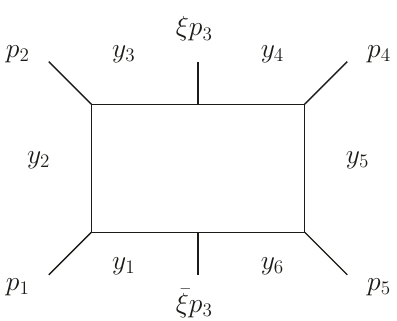
Figure 4 . Six-point dual space for the hexagon integral